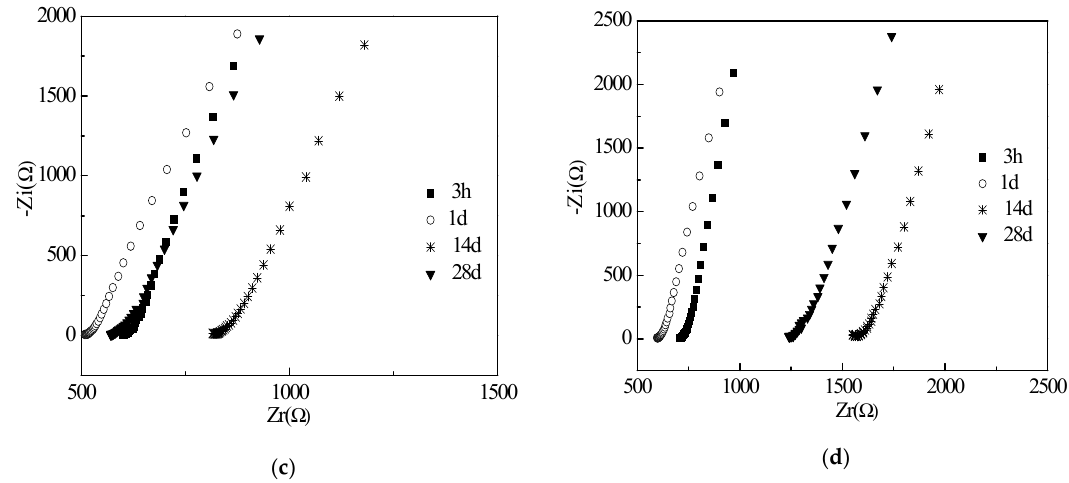
Figure 8. EIS curves of specimens with w/c ratio of 0.50: ( a ) RHA-10; ( b ) RHA-11; ( c ) RHA-12; ( d ) RHA-12.